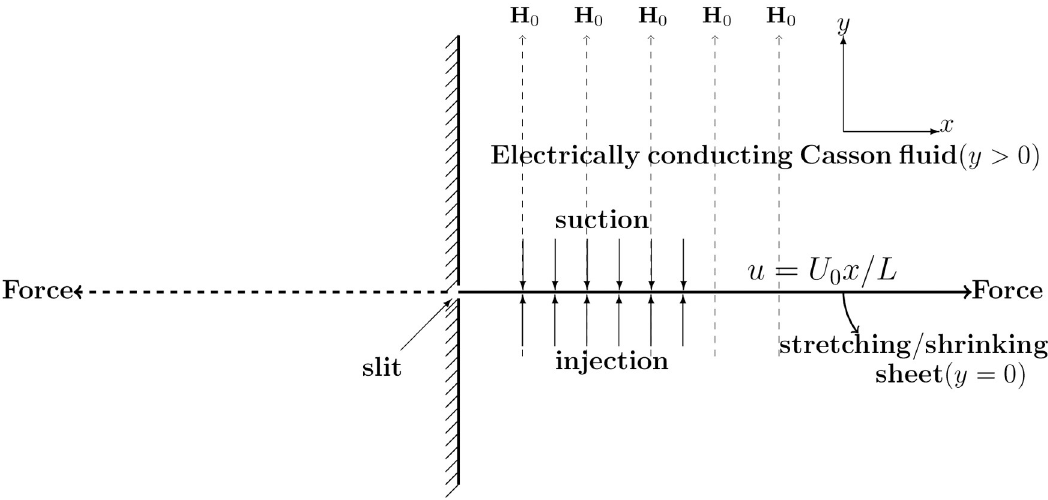
Fig 1. Physical model when the system is subjected to a vertical magnetic field H 0